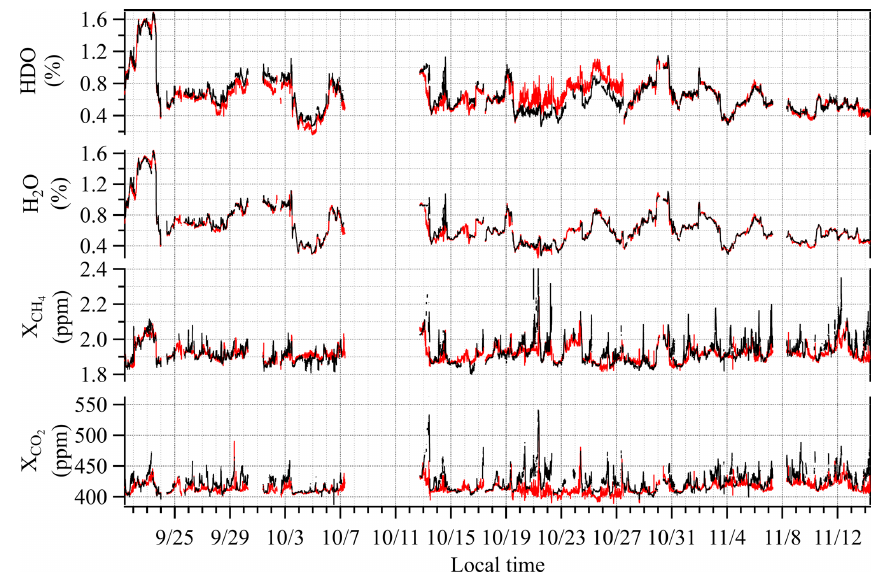
Figure 5. A total of 7.5 weeks of dual-comb spectroscopy data for the reference path (red) and the over-city path (black) smoothed to 5min time intervals. Enhancements in the over-city path relative to the reference path are observed in CO 2 and CH 4 but not in H 2 O or HDO. Note that the HDO concentration includes the HITRAN isotopic